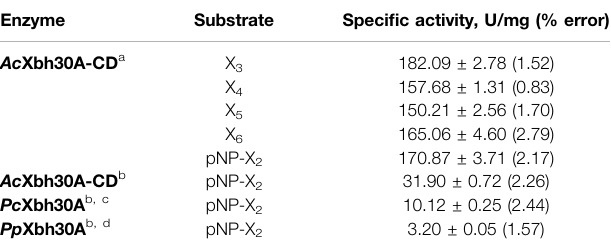
TABLE 2 | Kinetic constants of Ac Xbh30A in the hydrolysis of pNP-X 2 . Kinetic constant